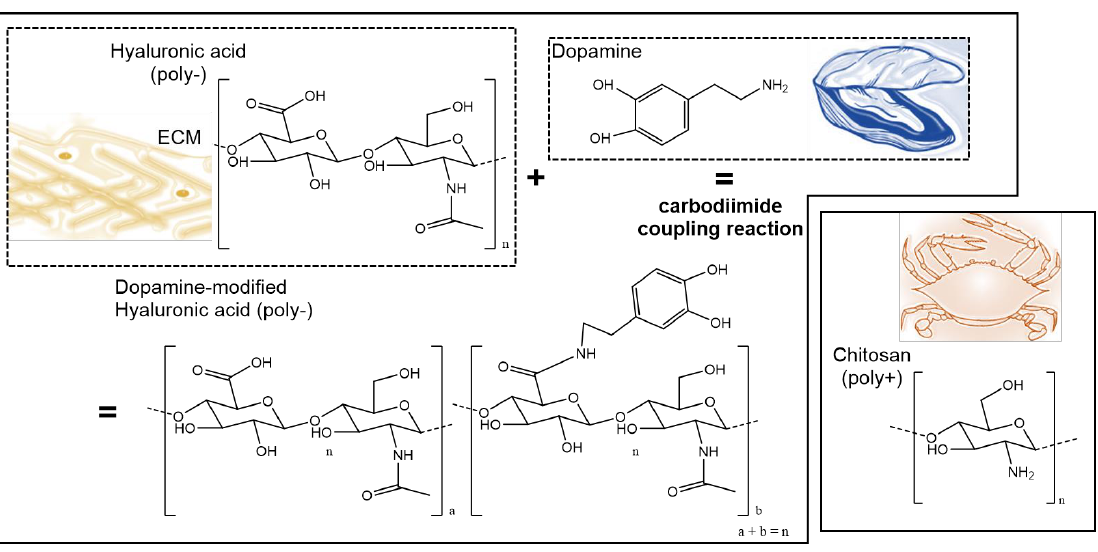
Figure 1. Chemical structure of hyaluronic acid (HA), dopamine (DN), and chitosan (CHT). Synthesis and chemical structure of dopamine-modified hyaluronic acid (HA-DN). ECM: extracellular matrix.